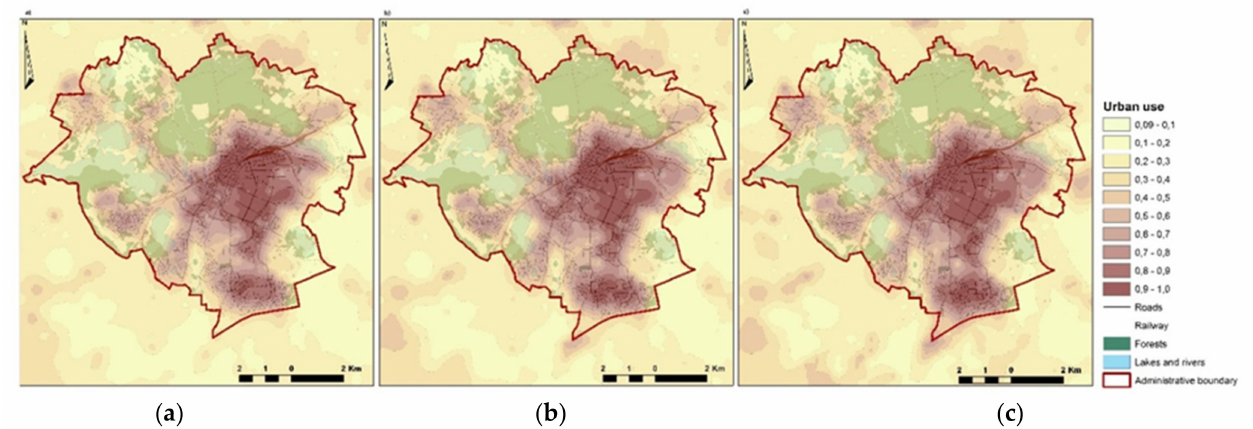
Figure 21. Urban use in the study area in the degree of membership interval of [0.00–1.00]: ( a )—2005; ( b )—2010; ( c )—2018. Source: [20].